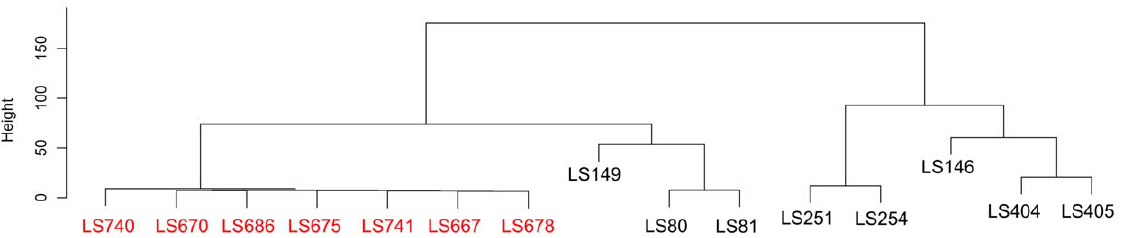
Figure 10. Hierarchical clustering based on the Robust Multi Array (RMA) analysis. Strains highlighted in red indicated the serotype 1/2b strains from the 2011 Cantaloupe outbreak.